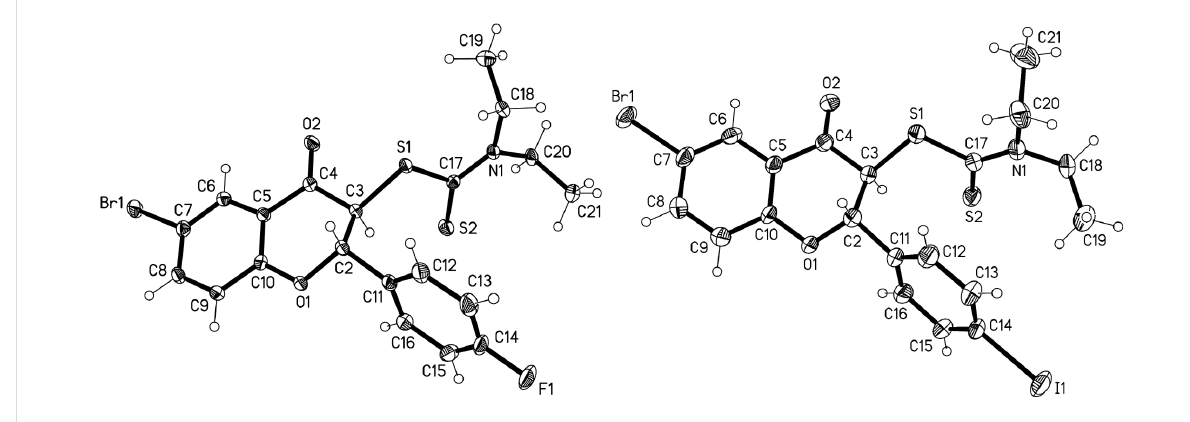
Figure 3: Molecular structures of 4d (left) and 4f (right). Ellipsoids represent 50% probability levels [24].